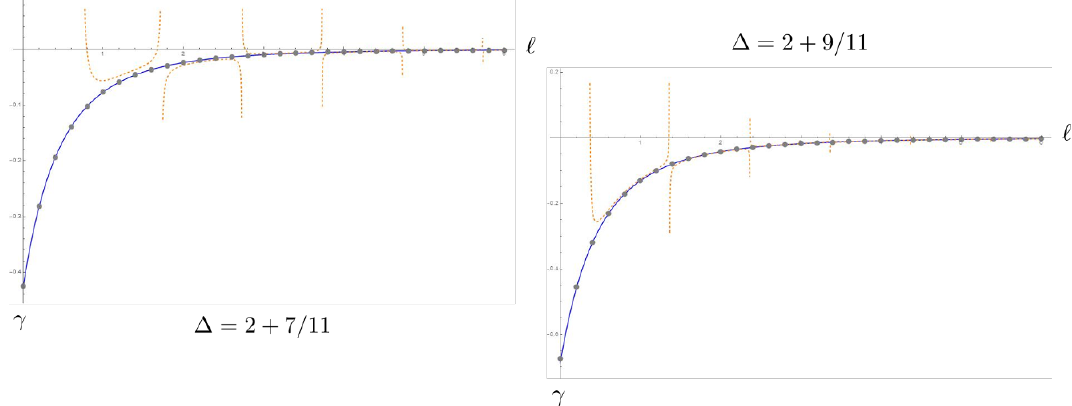
Figure 2 . The plot of the expression (2.36) obtained by evaluating the spectral integral is in tick blue, the expression (3.4) is in dashed orange and the (cid:12)rst three terms of the large spin expansion in 1 = J are the grey dots. In this plot we took d = 4 and (cid:28) 0 = 4, for (cid:1) = 2 + 7 = 11 (l.h.s.) and (cid:1) = 2 + 9 = 11 (r.h.s.). The expression (3.4) displays some oscillating singular behaviour which diminishes as (cid:1) approaches (cid:1) = 3. For (cid:1) (cid:21) 3 no non-analytic behaviour in 1 = J is observed. Remarkably the analytic result in spin matches the (cid:12)rst three terms in the large spin expansion up to very low spin with a very small error that is indistinguishable in the